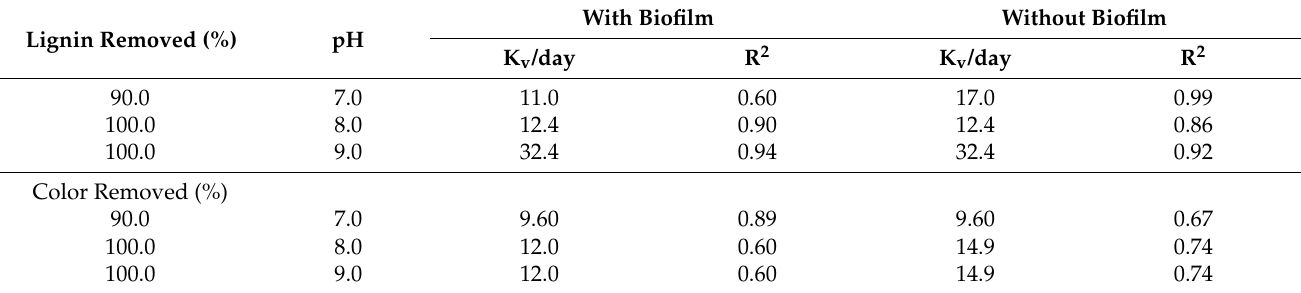
Figure 6. Removal of color from the effluent by bacterial strain RGM2262 at the different pHs studied. Table 2. Rate constants for the different treatments with bacterial strain RGM2262.